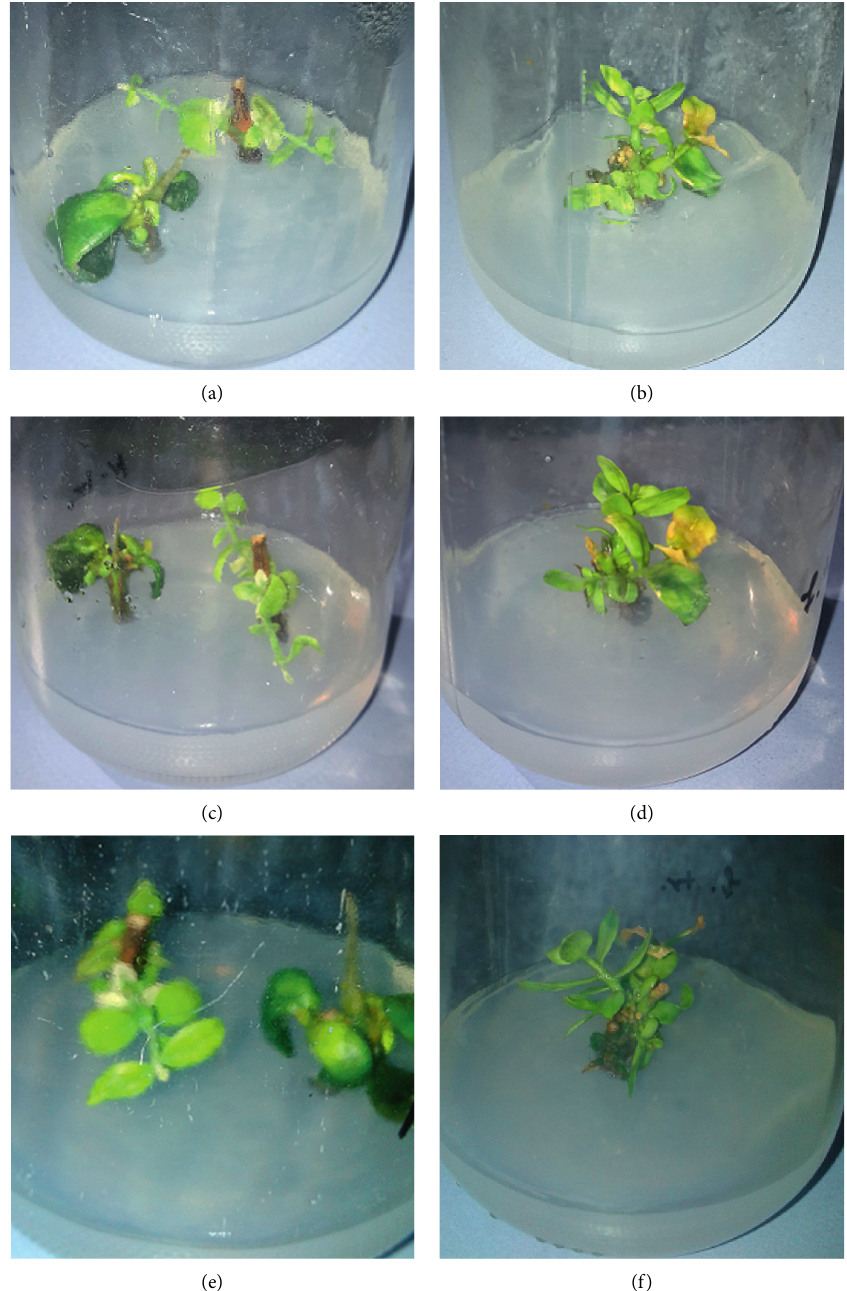
Figure 3: Jojoba grown in tissue culture, infected with either A. niger or A. flavus cells, and sprayed afterwards with FGCCC.(a), (c), and (e) Plant at days 0, 5, and 10, respectively, after treatment with A. niger cells then sprayed with FGCCC. (b), (d), and (f) Plant at days 0, 5, and 10, respectively, after treatment with A. flavus cells and then sprayed with FGCCC. Plant continues to grow without any sign of fungal growth on the tissue culture medium or plant